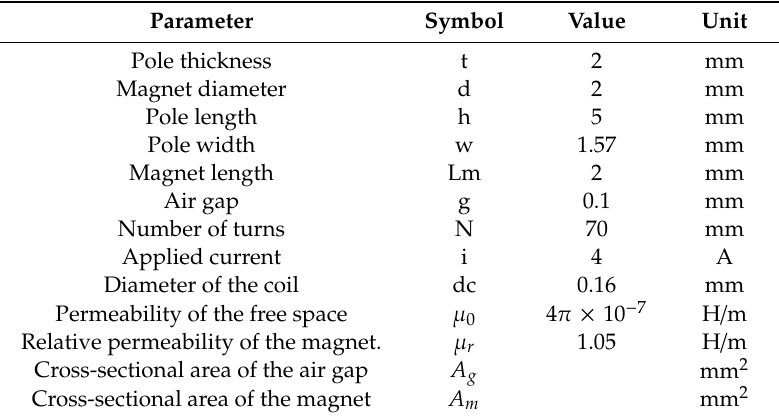
Figure 3. Electropermanent magnet device for holding the proposed gripper: ( a ) Schematic of the electropermanent magnet; ( b ) Flux leakage of the electropermanent magnet. Table 1. Parameters of the electropermanent device.